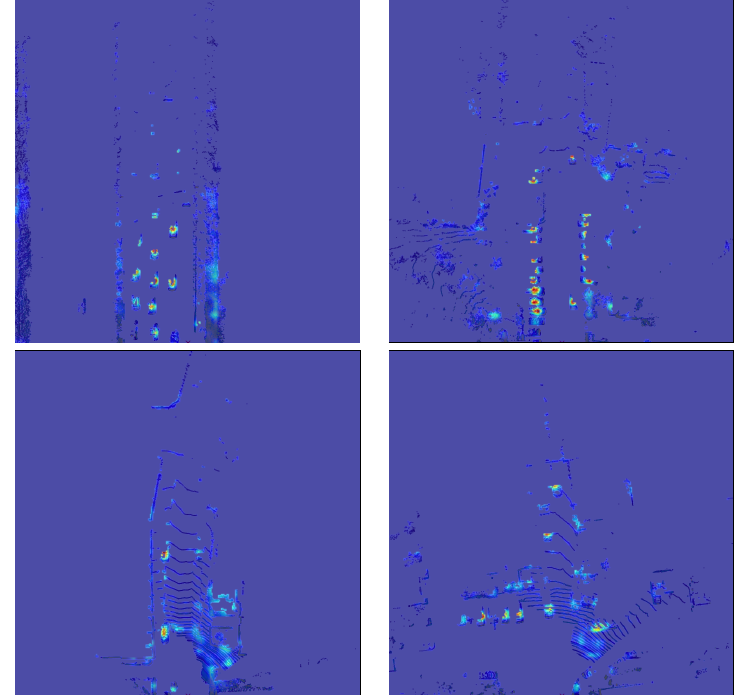
Figure 11. Final Grad-CAM adaptation results for a LiDAR pointcloud object detection network. Combining all of our experiments and findings, we were able to create our final pipeline for CAMs creation. This results in a high resolution, clear, and free of noise CAM heatmap that highlights important areas in an input pointcloud